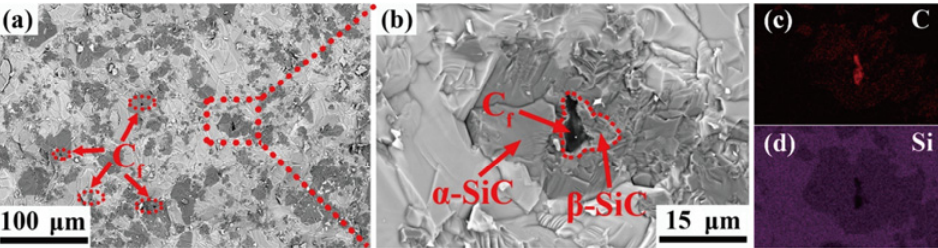
Fig. 13 Fractured morphologies of SiC composite with SiC:IM = 0.20: (a) back-scattered electron SEM; (b) high-magnification SEM micrograph; and (c, d) EDS mappings.